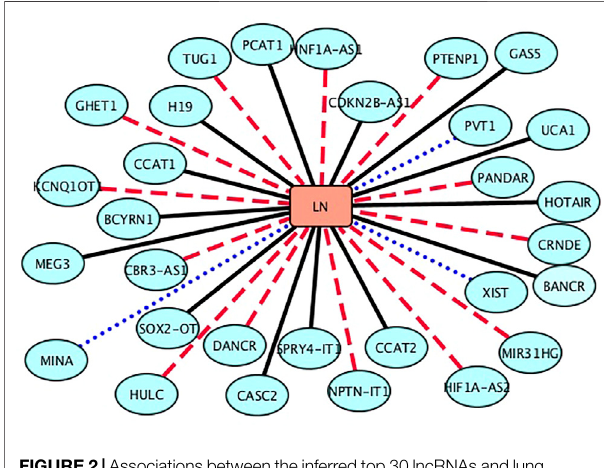
FIGURE 2 | Associations between the inferred top 30 lncRNAs and lung neoplasms (LN). Black solid lines represent known LDAs in the lncRNADisease database. Blue-dot lines represent LDAs that can be observed in the MNDR database. Red-dash lines represent LDAs predicted to be potential lncRNA biomarkers of